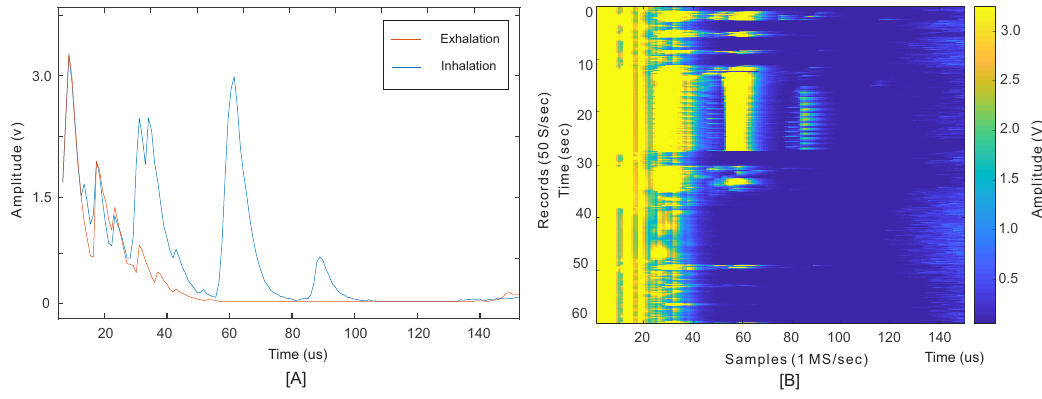
Figure 4. ( A ) An example of the obtained signal sampled at 1 Ms/s at the end of each inhalation